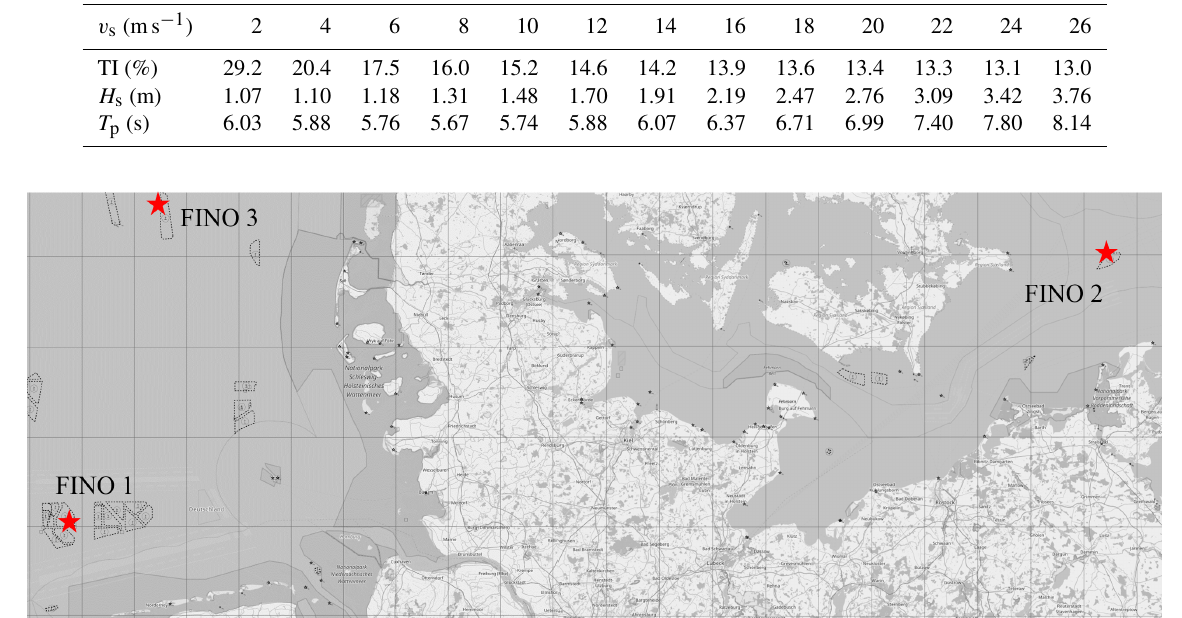
Figure 1. Positions of the three FINO platforms in the North and Baltic Sea, adapted from